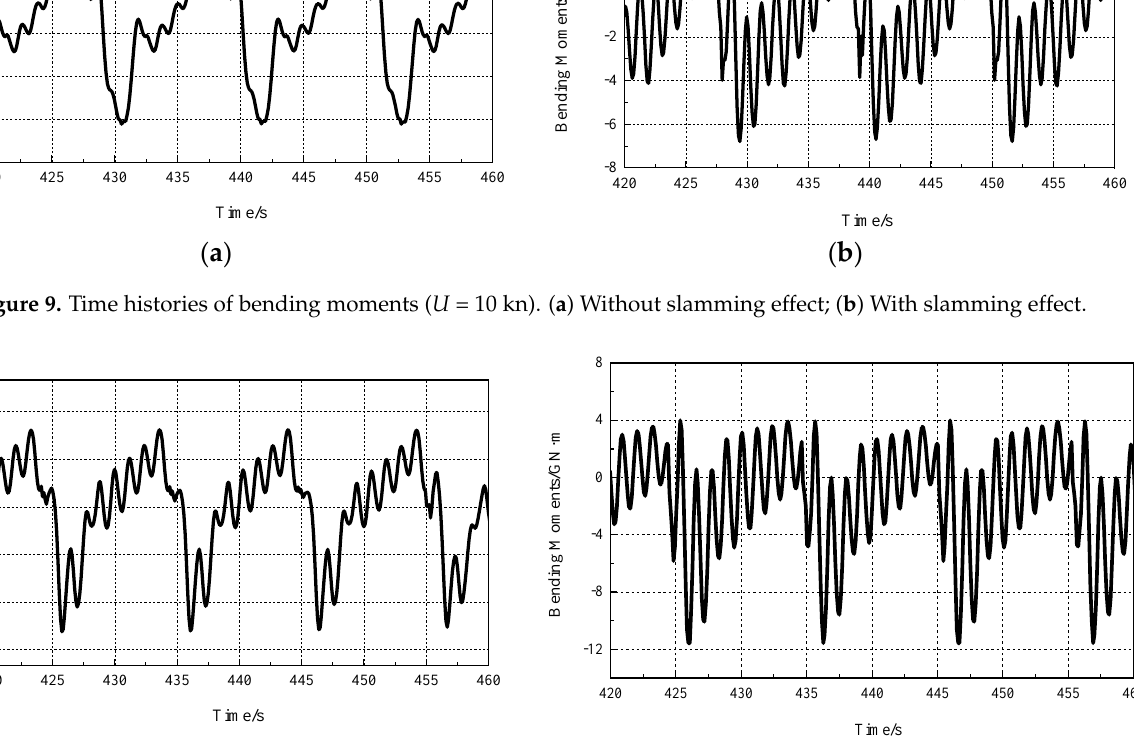
Figure 10. Time histories of bending moments ( U = 15 kn). ( a ) Without slamming effect; ( b ) With slamming effect.